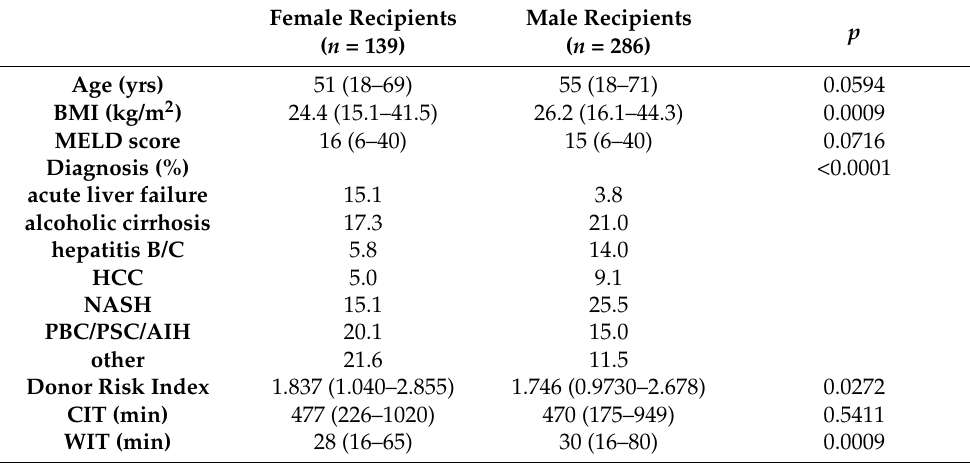
Table 1. Recipient, donor and surgical details stratified according to recipient